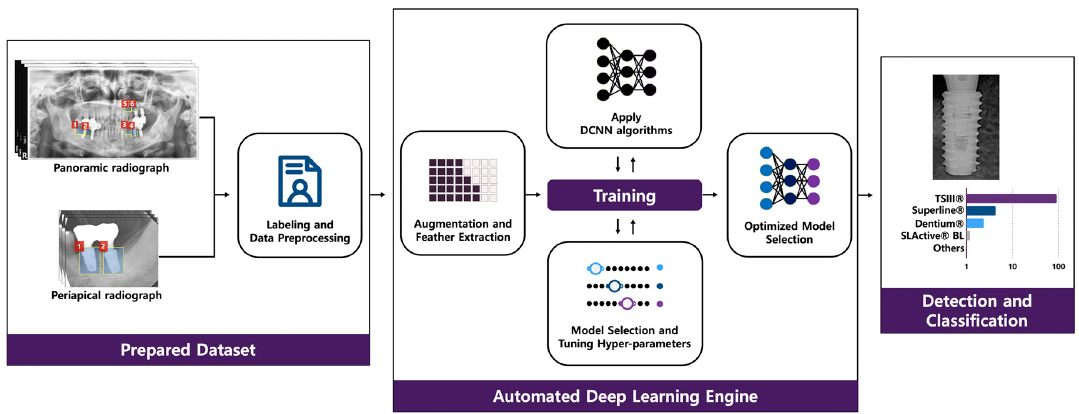
Figure 1. Overview of an automated deep convolutional neural network (DCNN) system.